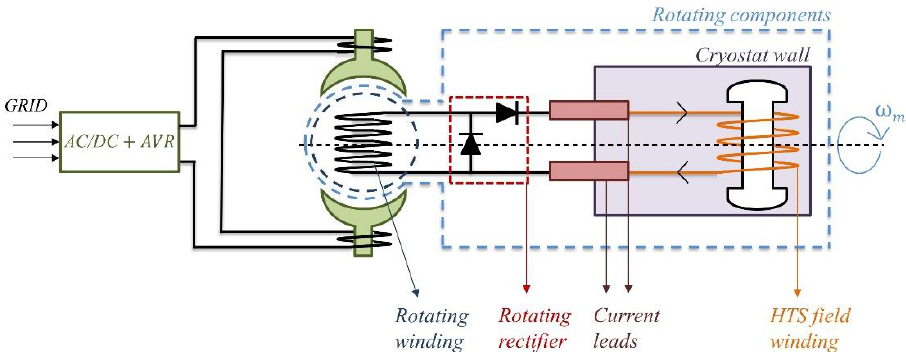
Figure 10. Contactless supply system of the rotor HTS field winding of the EcoSwing turbine, based on the warm rectifier flux pump.